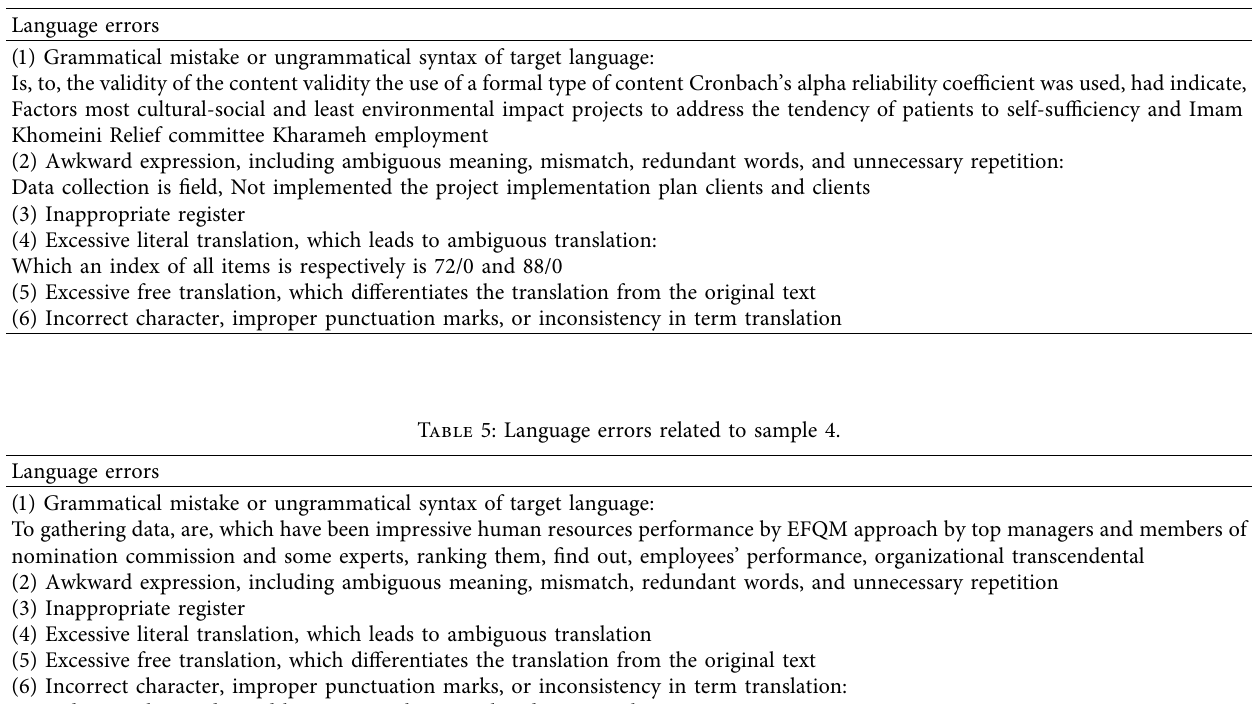
Table 4: Language errors related to Sample 3.